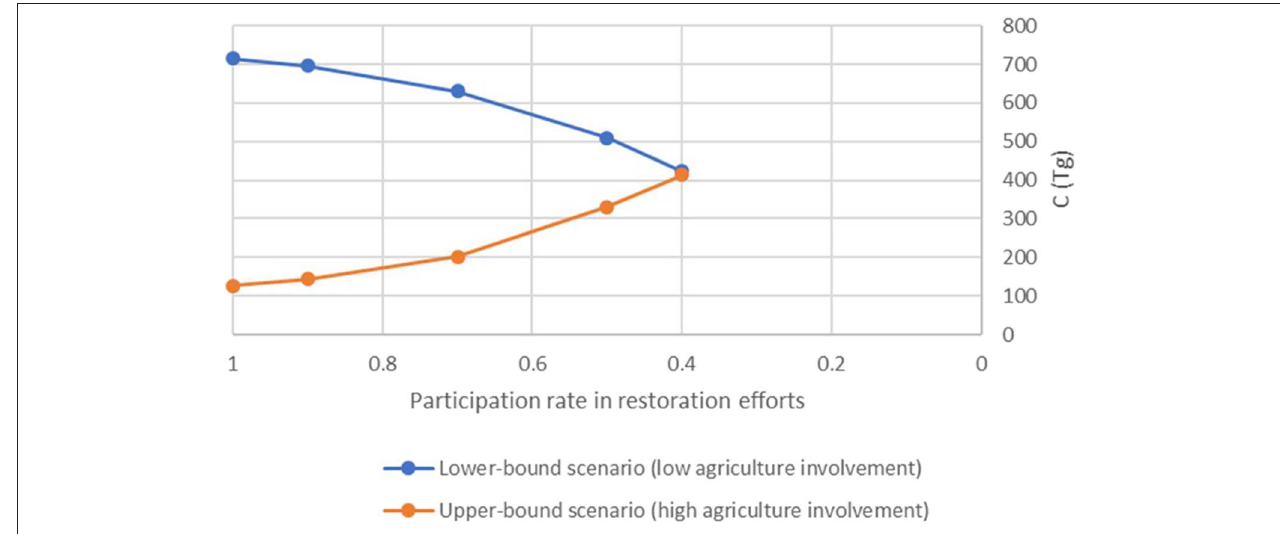
FIGURE 6 | Changes in above-ground biomass with adoption of restoration practices at different participation rate